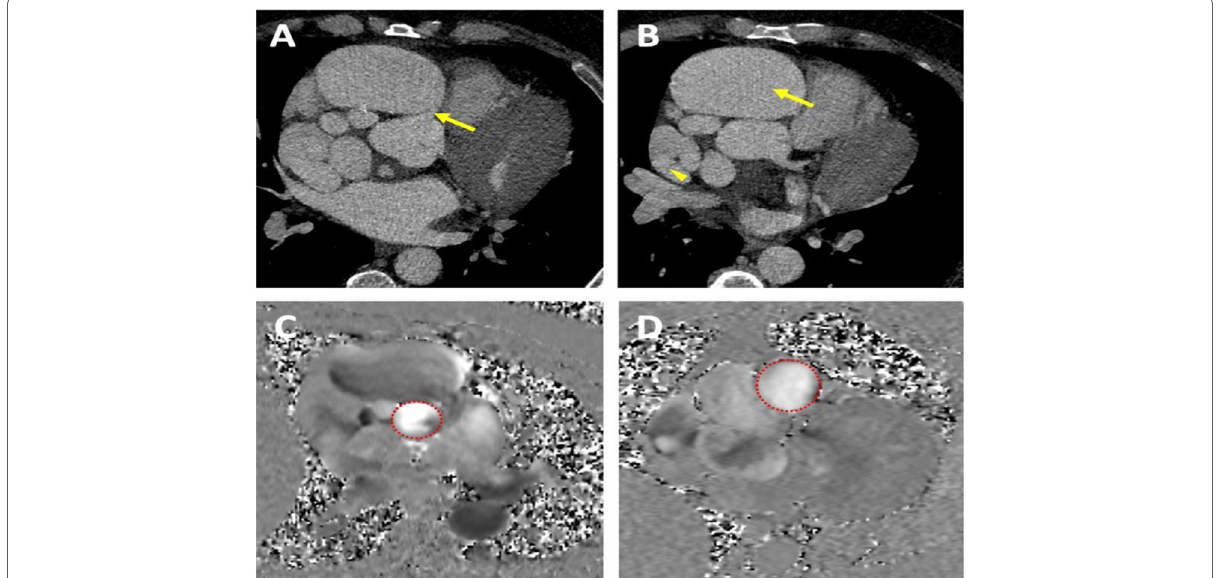
Fig. 1 Coronary computed tomography angiography (CCTA) images ( A , B ) and phase-contrast cardiac magnetic resonance (CMR) images ( C , D ). A Normal ostium of the right coronary artery (RCA) with short proximal normal segment (6 mm length, arrow). B Giant aneurysm of the RCA with dilatation up to 5.0 cm (arrow) and coronary artery fistula with a tortuous course, ultimately draining into the distal superior vena cava (SVC) (arrowhead). C Systemic blood flow (Qs) measured at the level of the proximal ascending aorta was 118 ml. D Pulmonary blood flow (Qp) measured at the level of the pulmonary trunk was 160 ml. Qp/Qs ratio was 1.36, indicating a significant left-to-right